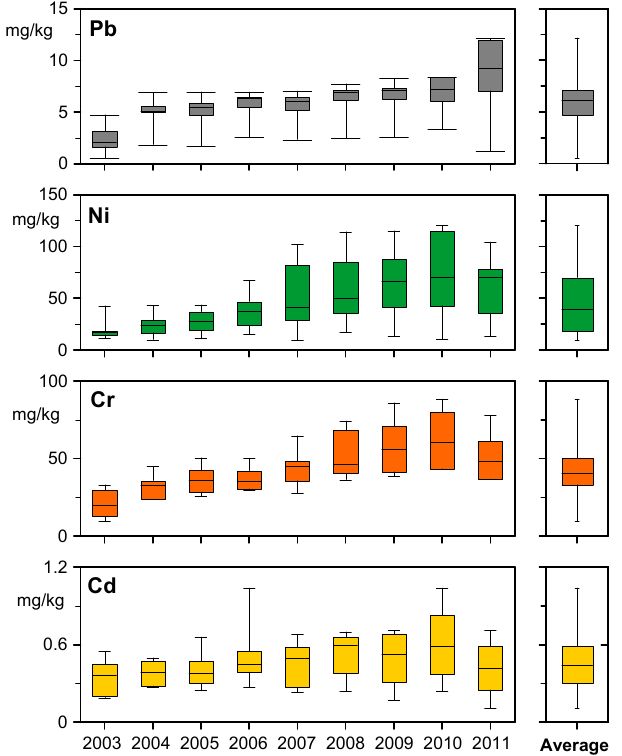
Figure 3. Boxplot of the evolution of metal content in soils over the years of the study.